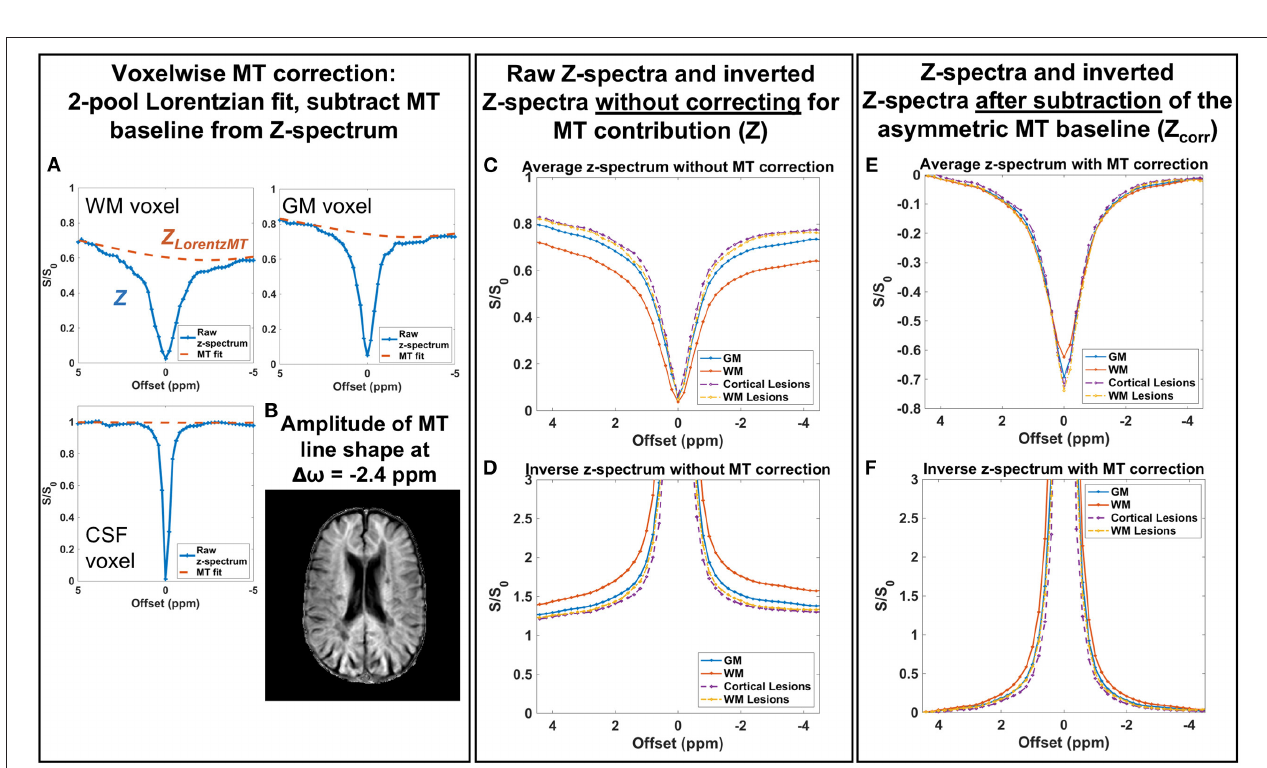
FIGURE 1 | A representative anatomical MP2RAGE image, CEST image (individual dynamic at 1 ω = − 5.0 ppm normalized to the unsaturated S 0 data), tissue segmentation, and R 1 map are shown for a healthy volunteer (top: 35-year-old female) and a patient with MS (bottom: 46-year-old female, EDSS = 2, duration = 1 year). All image volumes were registered to the 10 mm-thick CEST slice.